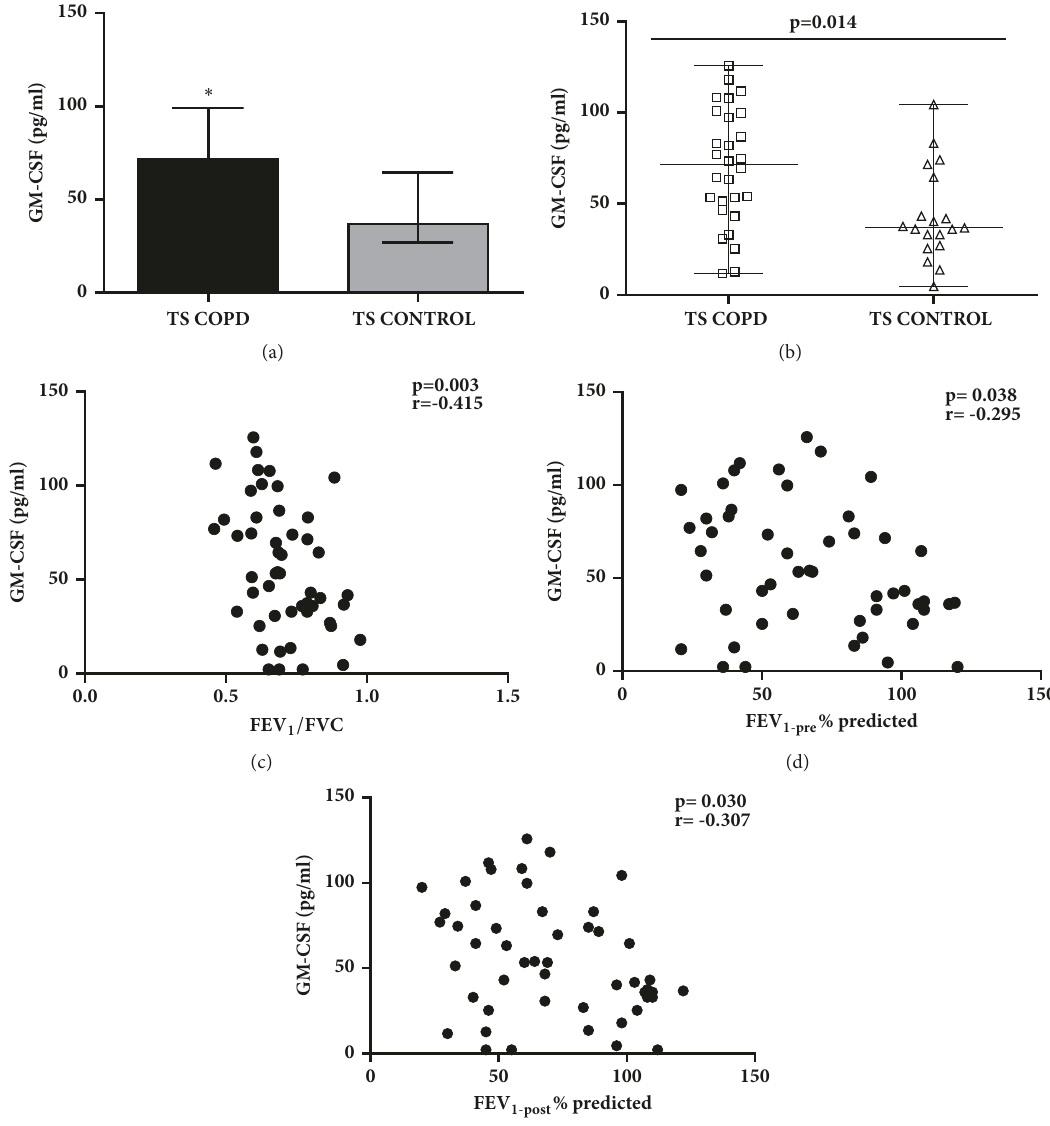
Figure 1: Serum concentrations of granular macrophage colony stimulating factor (GM-CSF) and corresponding correlation with lung function parameters among long-term smokers with or without chronic obstructive pulmonary disease (COPD) . (a, b) GM- CSF concentrations were increased in TS COPD group compared to TS CONTROL group (p=0.014); inverse correlation of GM-CSF concentrations to (c) FEV 1 /FVC and (d) FEV 1( pre ) and FEV 1( post ) was detected in the study cohort. Data is presented as median (25th- 75th percentile); TS COPD: n=30 and TS CONTROL: n=20; ∗ p < 0.05 was considered as statistically significant. COPD : chronic obstructive pulmonary disease; FEV 1 /FVC : forced expiratory volume 1 second /forced vital capacity; FEV 1 : forced expiratory volume 1 second (pre) prebronchodilator challenge; FEV 1 : FEV 1 postbronchodilator challenge; TS COPD : tobacco smokers with COPD; TS CONTROL : (post) tobacco smokers without